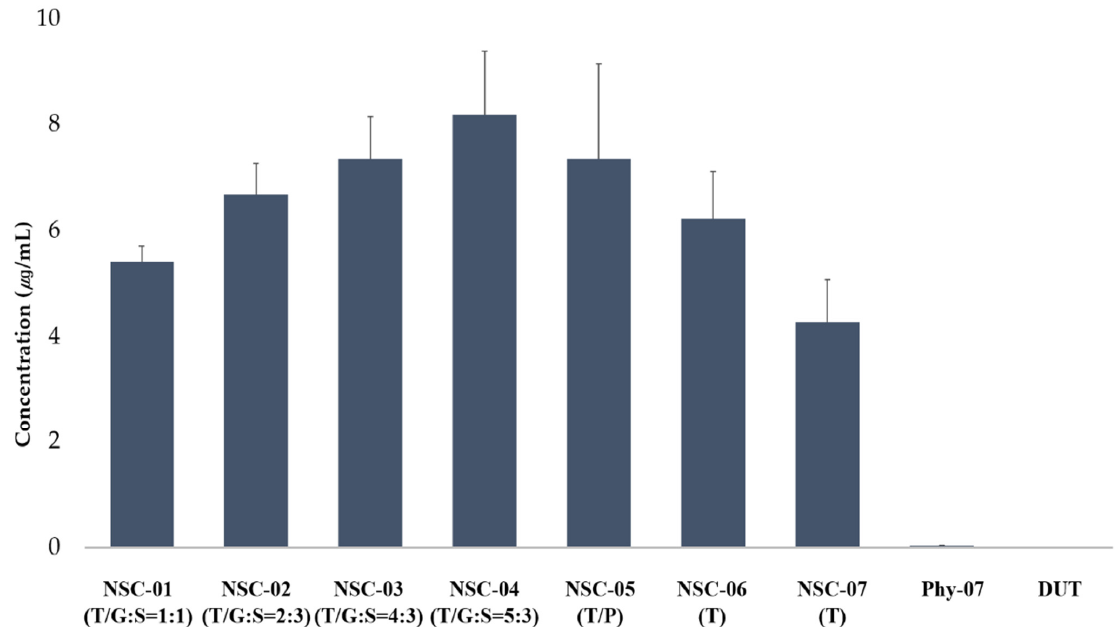
Figure 4. The solubility of dutasteride in NSCs by lipid and silica carrier composition ratio, and in NSC by lipid composition types ( n = 3). The solubility of dutasteride in physical mixture of DUT and silica carrier, and pure DUT is also shown. Abbreviations: DUT, dutasteride; NSC, nanoporous silica entrapped lipid-drug complex; Phy-07, Physical mixtre-7.